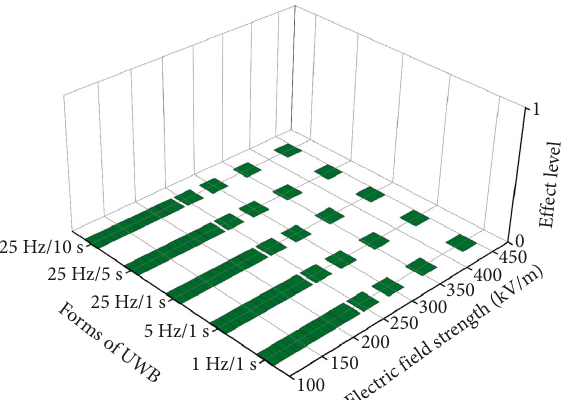
Figure 23: Test data of detector 3 (with shield).